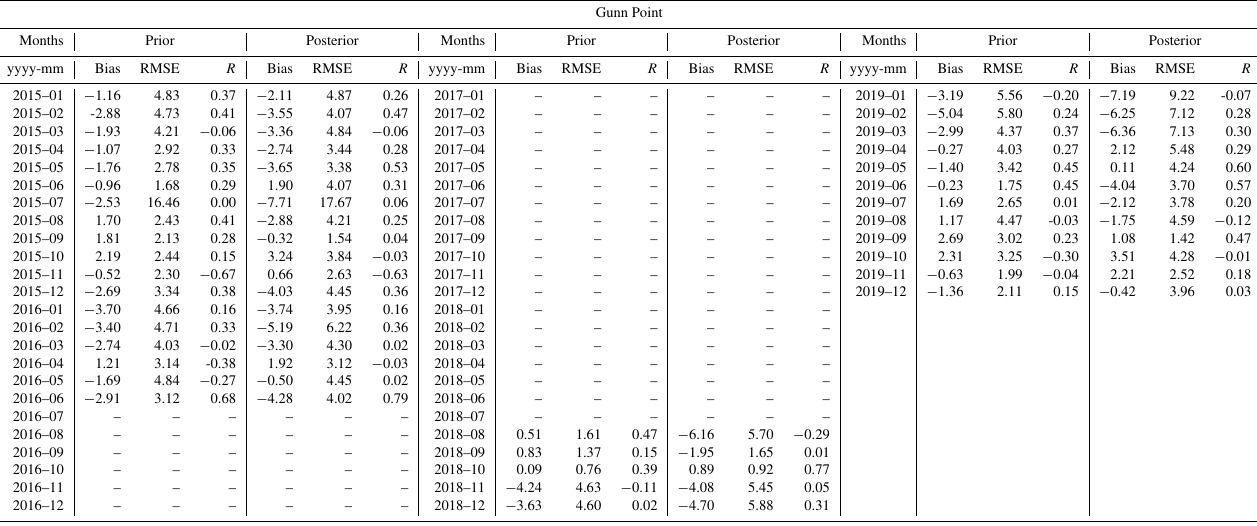
Table G2. Analysis of the residual between CMAQ prior and posterior simulation values and the Gunn Point site for the 2015–2019 period, showing the averaged bias (Bias), root-mean-square error (RMSE), and Pearson coefficient ( R ). GunnPoint